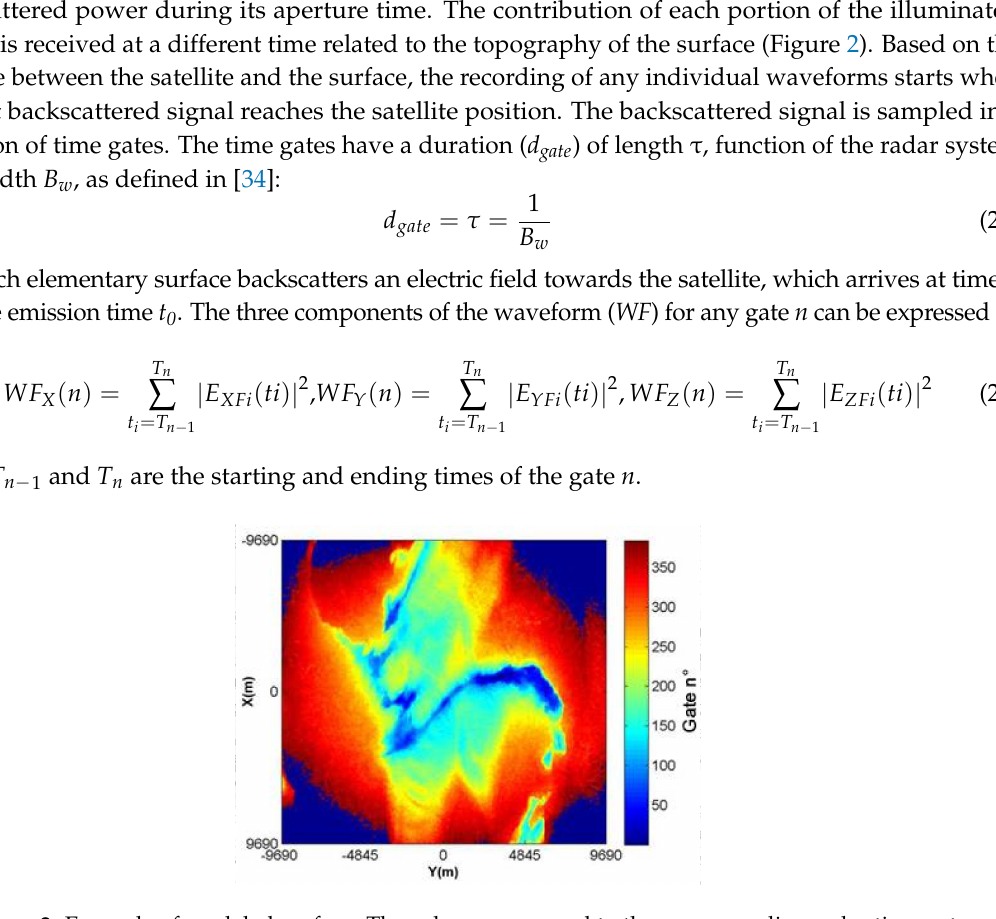
Figure 2. Example of modeled surface. The colors correspond to the corresponding radar time gate (here for 384 time